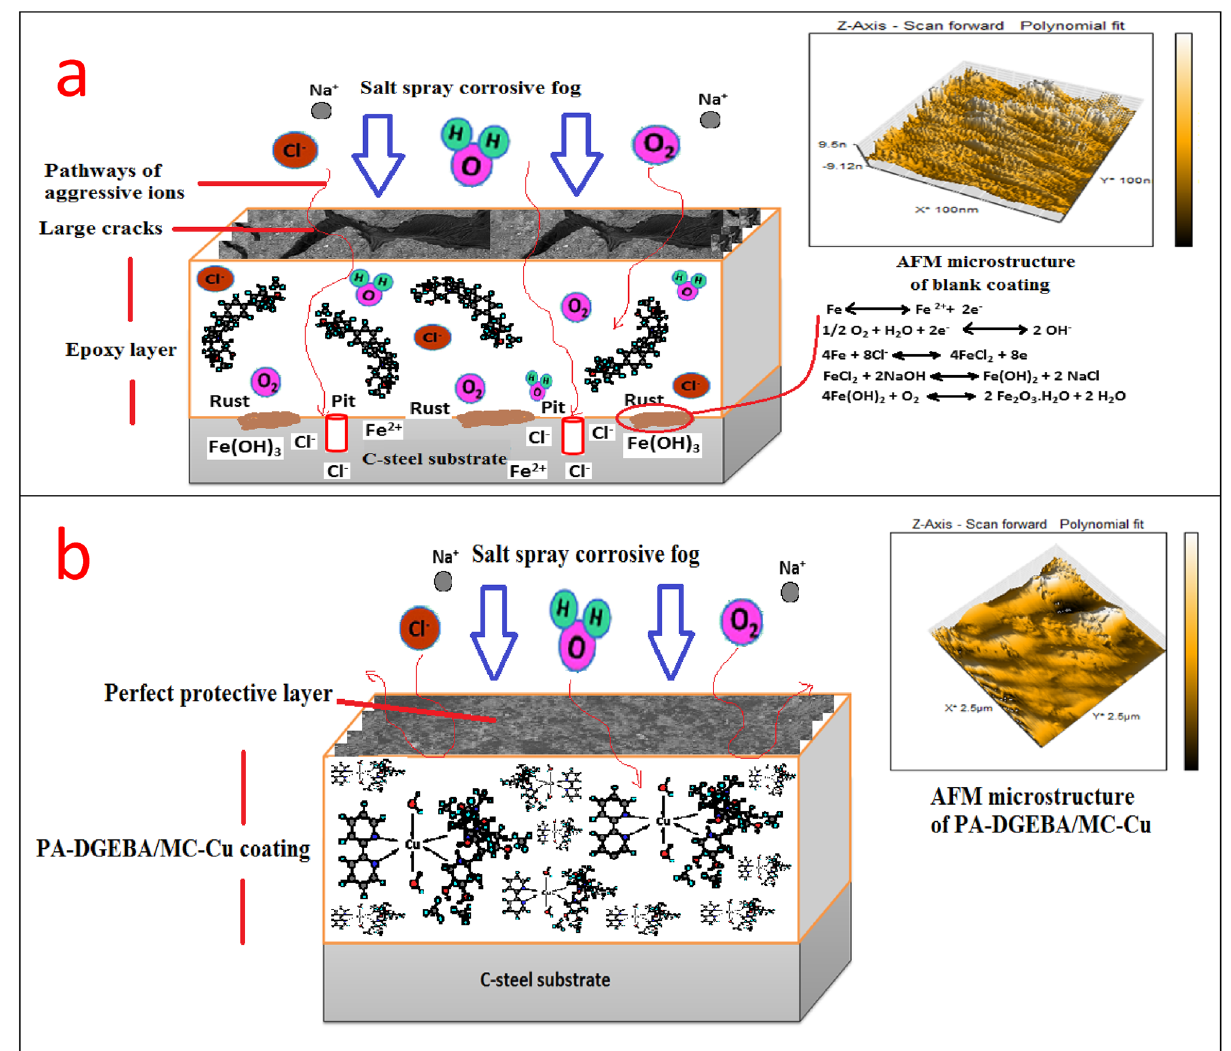
Figure 10. The predicted protective mechanisms of ( a ) Blank unmodified epoxy, and ( b ) PA-DGEBA/MC-Cu coating after the exposure to aggressive salt spray